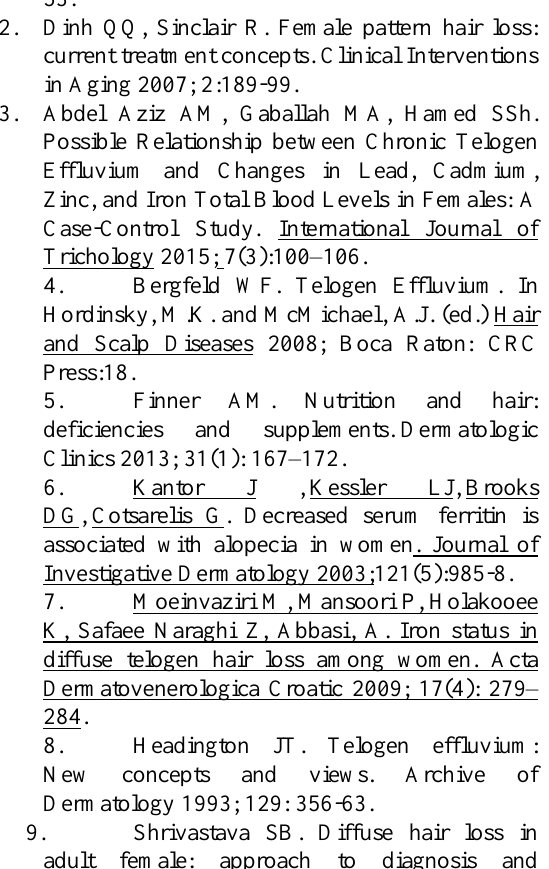
Headington JT. Telogen